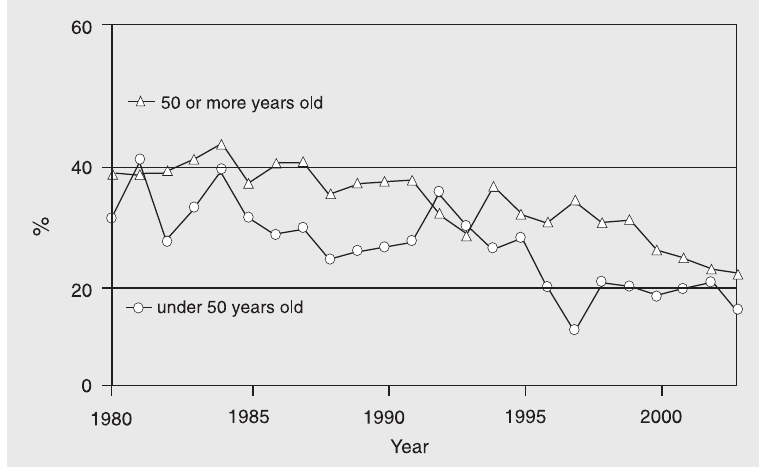
Figure 1. Uterine cancer deaths without specification of subsite in São Paulo, Brazil, 1980- 2003. Data are reported as percent of total certified cervical cancer death.